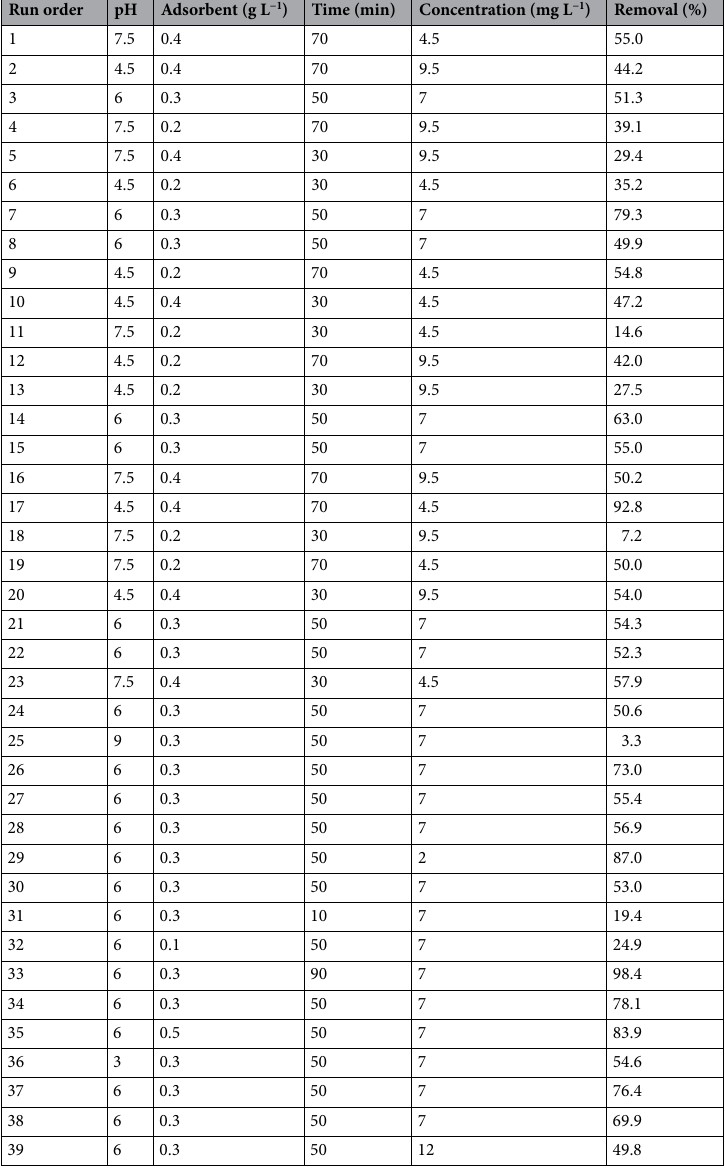
Table 1. CCD matrix ranges and their response to fluoride adsorption by bivalve